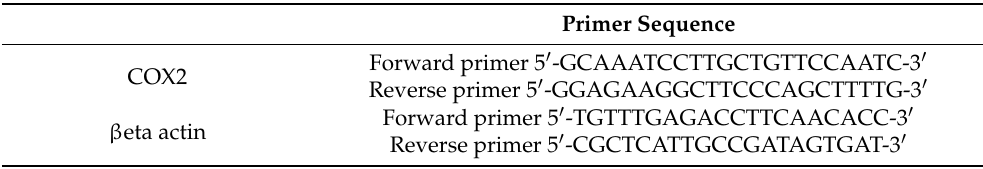
Table 2. The primer sequence of the studied